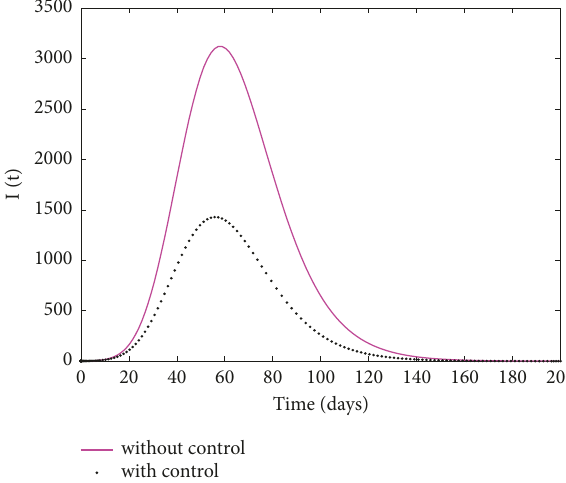
Figure 13: Behaviour of COVID-19-infected individuals with and without lockdown control.